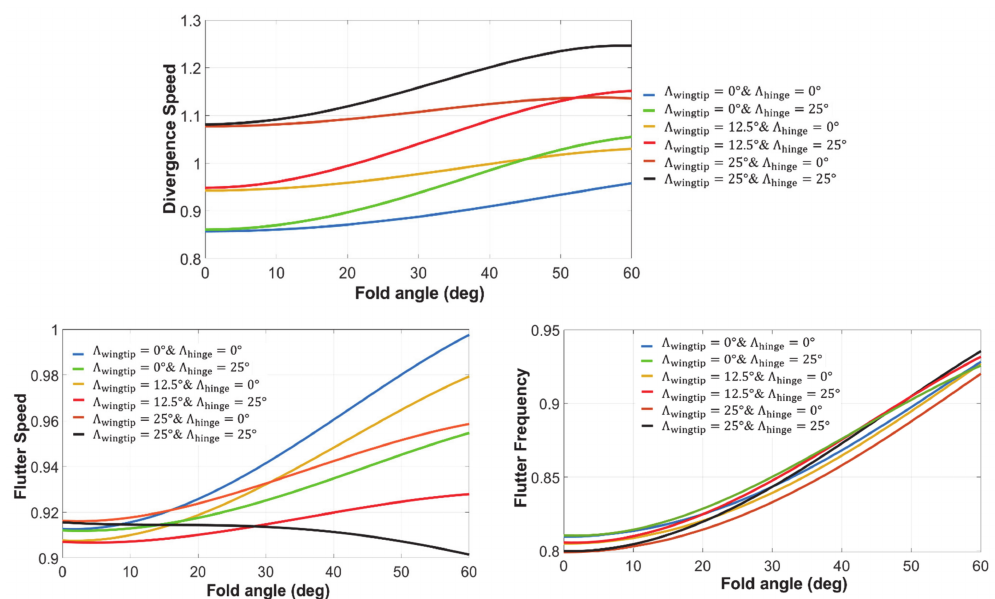
Figure 15. Effect of wingtip sweep on